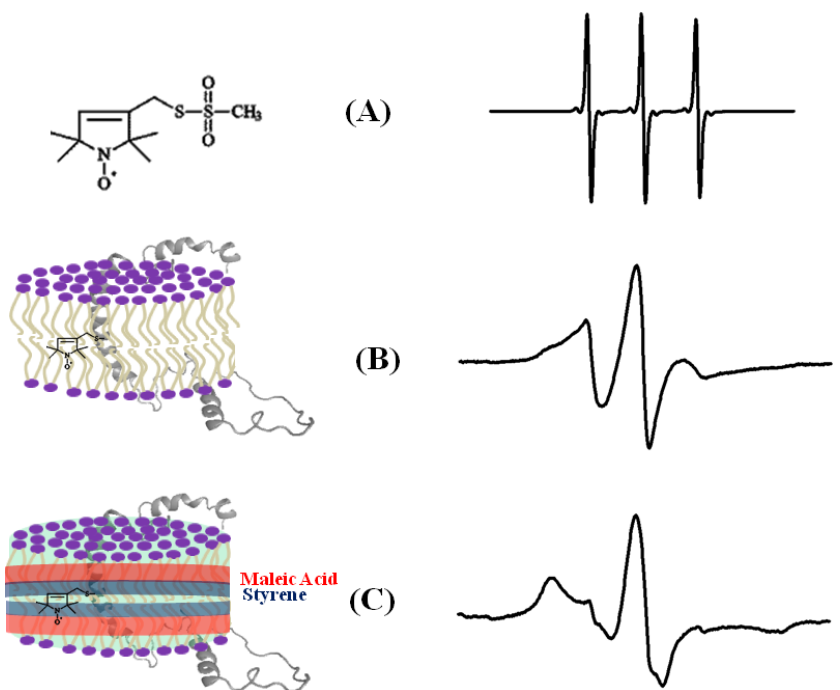
Figure 4. An illustrative example of the EPR spectra for a spin-labeled membrane protein in di ff erent membrane environments. ( A ) A free MTSL spin label in solution, ( B ) MTSL spin label on a F56 C-KCNE1 membrane protein in a lipid bilayer, ( C ) MTSL spin label on a F56C-KCNE1 membrane protein in lipodisq nanoparticles. The CW-EPR spectrum for lipodisq nanoparticle samples also shows a minor peak due to free spin labels. (Adapted from [69] with